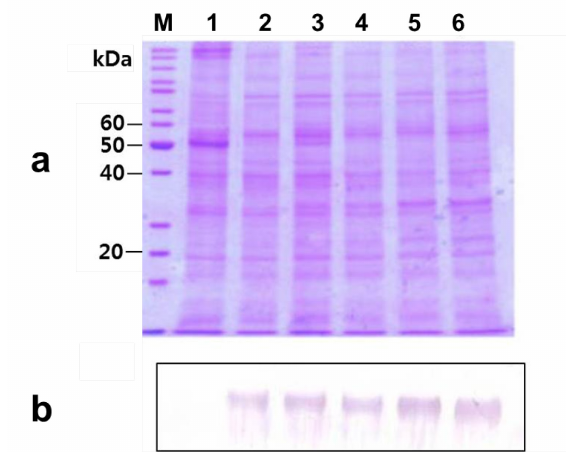
Figure 3. Recombinant phytase protein was identified from the extracts of agro-infiltrated leaves of N. benthamiana with Agrobacterium containing pPZP212-phy. ( a ) Coomassie blue-stained 10% SDS-PAGE gel; ( b ) Western blot analysis of identical gel in ( a ). Lane M, molecular weight markers; Lane 1, mock infiltrated control; Lanes 2–6, agro-infiltrated leaves at 1, 2, 3, 4 and 5